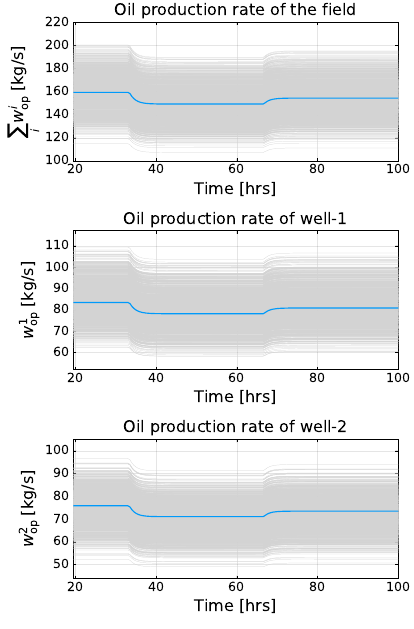
Figure 3: Prior model